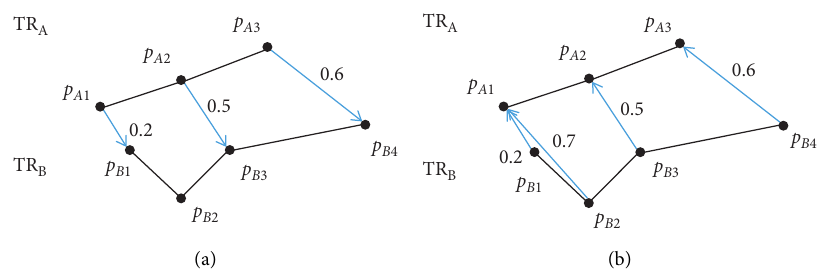
Figure 2: Hausdorff distance between two